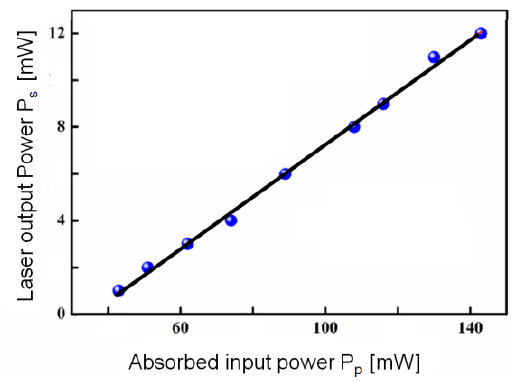
Figure 2. Characteristic of the Nd 3+ /Ho 3+ co-doped tungsten tellurite fiber laser. The blue points are measured. Figure adapted from [18].